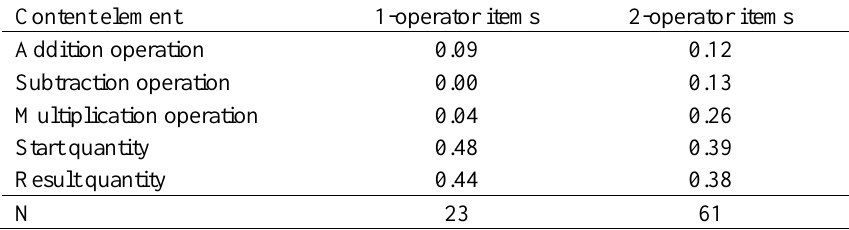
Proportion of Missing-mathematical-content errors of each